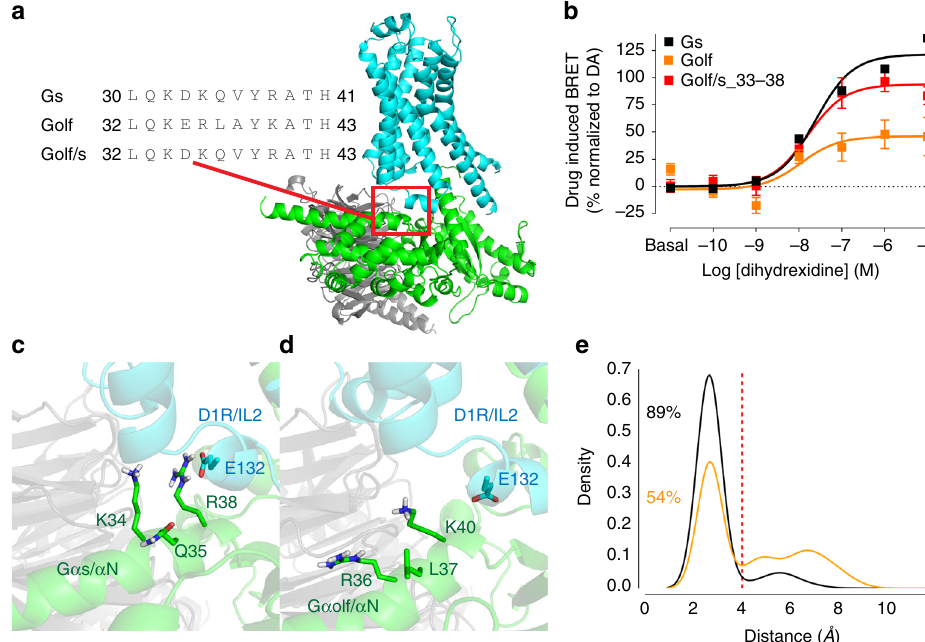
Fig. 2 a Homology modeling of Gs (green) coupling to D1R (cyan) based on β 2AR-Gs crystal structure (PDB: 3SN6) with the amino acid alignment among Gs (top row), Golf (middle row), and Golf/s_33 – 38 chimera (bottom row). b Dose-response curves of DHX-induced BRET between D1R-Rluc and Gs- Venus, Golf-Venus, or Golf/s_33 – 38-Venus (black, orange, and red respectively). BRET values are normalized to E max values obtained by DA with corresponding G α -Venus constructs. c , d Close-up views of the simulated interface between D1R and Gs ( c ) or D1R and Golf ( d ) at the intracellular loop 2 (IL2) of D1R and N-terminal α -helix ( α N) of G α subunit. e Frequency density distribution plot of 50 ns simulation for D1R-Gs (black) and D1R-Golf (orange). Proportions of salt bridge occurance ( < 4 Å) in the simulation are shown in percentage. The error bars represent (Supplementary Fig. 3C, solid and hatch bars vs. mosaic bar). In non-electroporated S49 cyc- cells, DHX or isoproterenol ( β -adrenergic receptor agonist) was added to demonstrate the lack of Gs/olf proteins, as there was no AC activation (Supple- mentary Fig. 3D, green mosaic and purple mosaic). The effect of isoproterenol was rescued by Golf or Gs electroporation (Sup- plementary Fig. 3D, purple solid and hatch bars). Finally, a BRET-based cAMP biosensor was used to verify the speci fi city and potency of SKF81297 and DHX in HEK293T cells (Supple- mentary Fig. 4A, B, E, F). Propranolol (1 µ M) was added to inhibit DA activation of β -adrenergic receptors (Supplementary Fig. 4E, F,